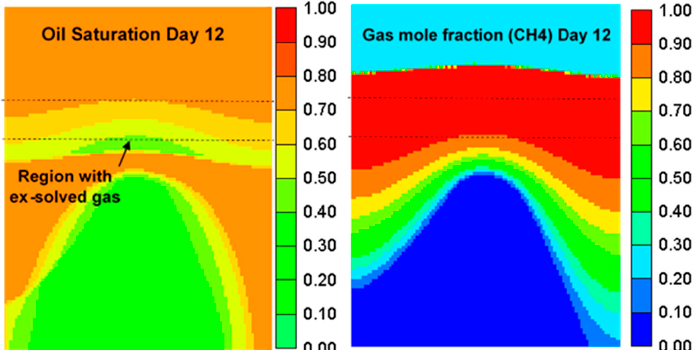
Figure 21. 2D images of oil saturation ( left ) and gas mole fraction (CH4) ( right ) distributions at the steam–oil interface for the VE model.